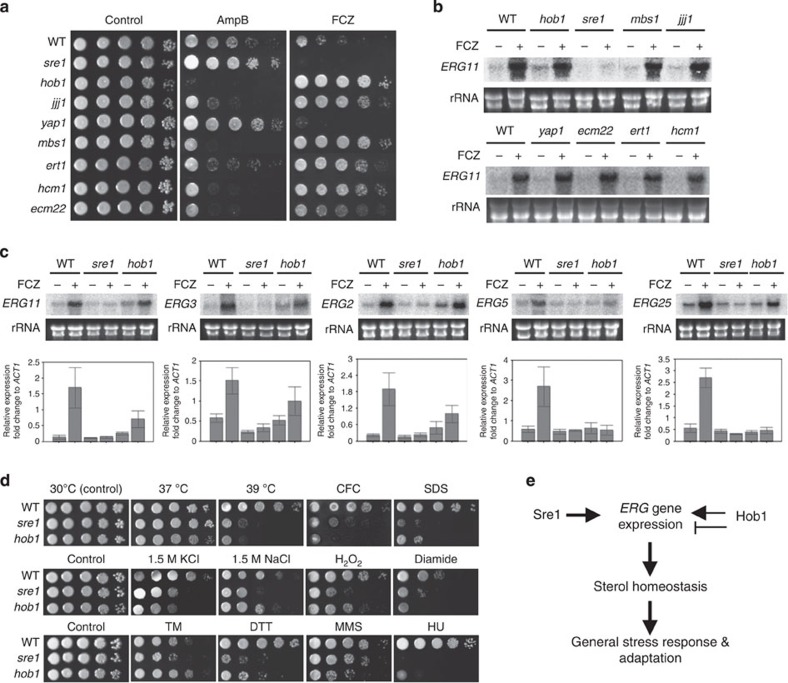
TFs regulating sterol biosynthesis genes govern general environmental stress responses and adaptation in C. neoformans.(a) TF mutants showing opposite patterns of susceptibility to fluconazole (FCZ) and amphotericin B (AmpB). WT strain H99 and TF mutants grown overnight were 10-fold serially diluted (1 to 104), and then spotted onto YPD containing the following antifungal drugs: 15 μg ml−1 FCZ or 1.5 μg ml−1 AmpB. (b) Northern blot analysis was performed with a ERG11-specific probe and the total RNA in cells treated or not treated with 10 μg ml−1 FCZ. (c) Northern blot assay was performed with ERG gene-specific probes. Quantitative reverse transcription–PCR analysis was performed with each ERG gene-specific primer using complementary DNA synthesized from the total RNA in cells treated or not treated with 10 μg ml−1 FCZ. Duplicate technical experiments with two or more biological samples were performed. Representative images from independent experiments for each ERG gene are shown. Error bars indicate s.d. (d) The role of Sre1 and Hob1 in environmental stress responses and adaptations. Strains grown as described in a were spotted onto YPD containing the stress-inducing agents: 3.5 mM H2O2, 2.5 mM diamide, 0.3 μg ml−1 tunicamycin (TM), 15 mM dithiothreitol (DTT), 5 mg ml−1 calcofluor white (CFW), 0.03% SDS, 0.04% methyl methanesulfonate (MMS) or 100 mM hydroxyurea (HU). (e) The proposed model for the role of Sre1 and Hob1 in the sterol homeostasis and general stress responses of C. neoformans.